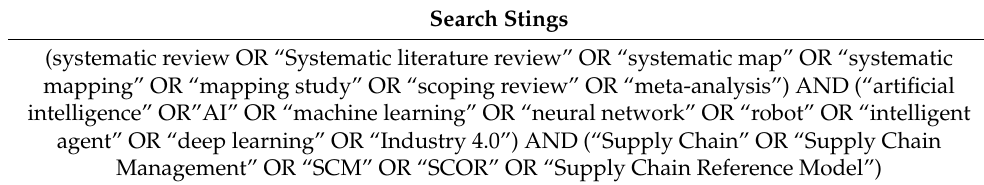
Table 4. Search strings used in the library